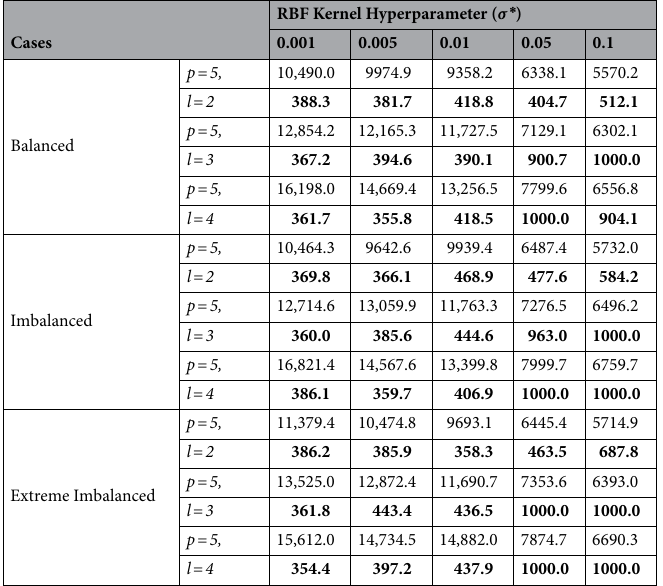
Table 3. KDE Control Limit and ARL 0 for several RBF Kernel Hyperpameters ( σ ∗ ). Bold values represent the ARL 0 (In-control